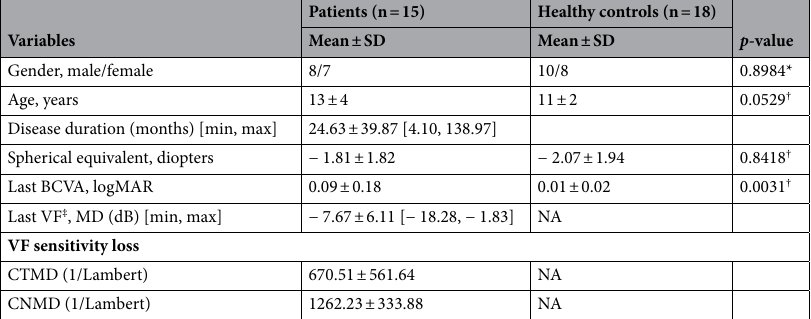
Table 1. Characteristics of pediatric and juvenile craniopharyngioma patients and healthy controls. BCVA best corrected visual acuity, MD mean deviation, NA not applicable, SD standard deviation, VF visual field, CTMD central temporal mean deviation, CNMD central nasal mean deviation. *Chi-squared test. † Wilcoxon rank-sum test. ‡ Humphrey Field Analyzer using the 30–2 SITA-standard protocol.